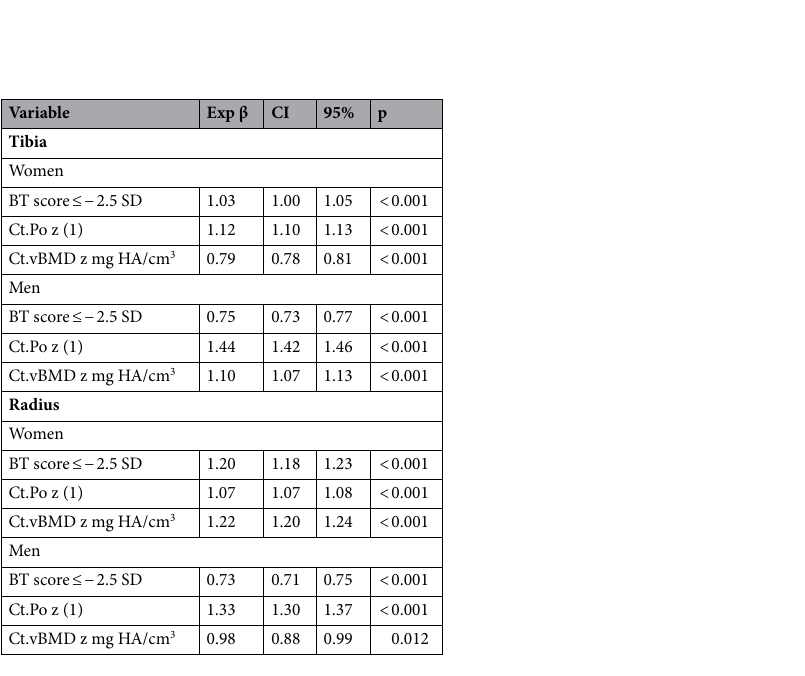
Table 6. Regression models for calcium content using bone mineral density (DXA) and HR-pQCT parameters at the tibia and radius stratified for sex. Exp β equation coefficient, CI confidence interval, SD standard deviation, BT score bone T -score, Ct. Po cortical porosity, z z score, Ct.vBMD cortical volumetric density.